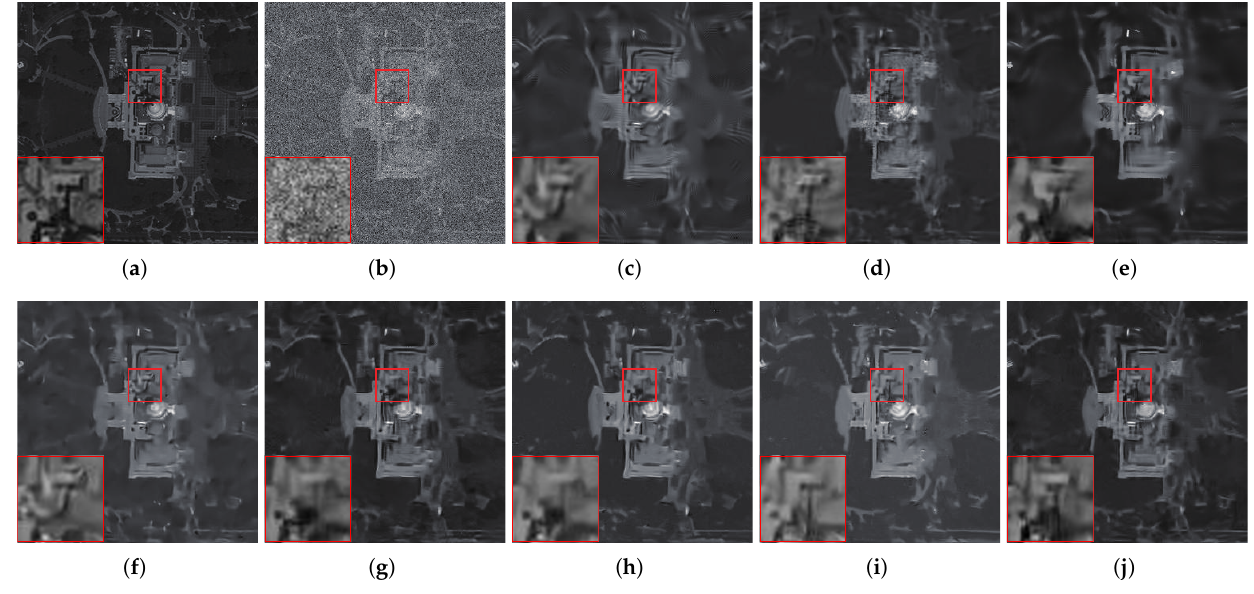
Figure 9. Visual comparison of experiments on the Multi-WDC image. ( a ) Ground-truth. ( b ) Noised ( σ = 40). ( c ) NCSR [43]. ( d ) WSSR [6]. ( e ) DnCNN [18]. ( f ) DKSVD [68]. ( g ) DCDicL [73]. ( h ) LRR- CNN [74]. ( i ) DLRP [75]. ( j ) Proposed.